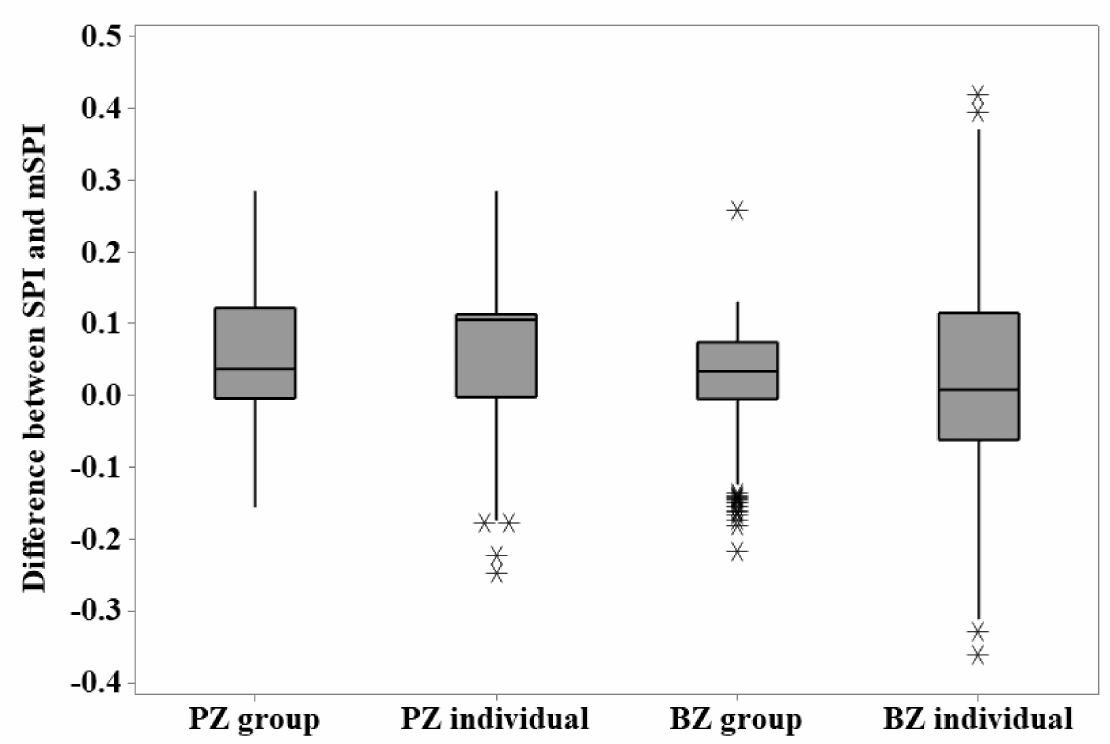
Figure 3. The difference between the SPI and mSPI calculated for group and individual data points from each zoo’s flamingo